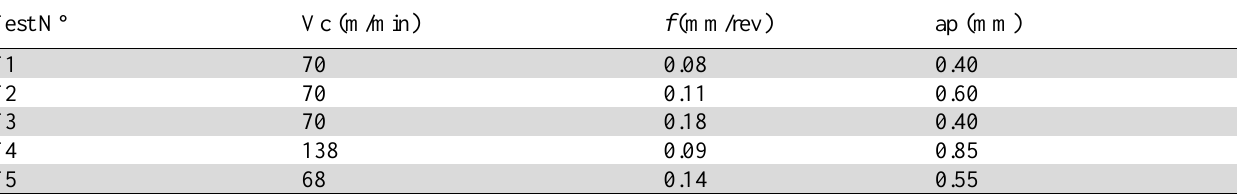
Cutting conditions used in turning confirmation